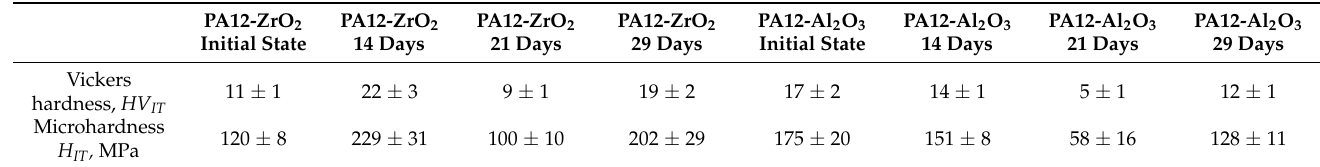
Table 7. Hardness of tested